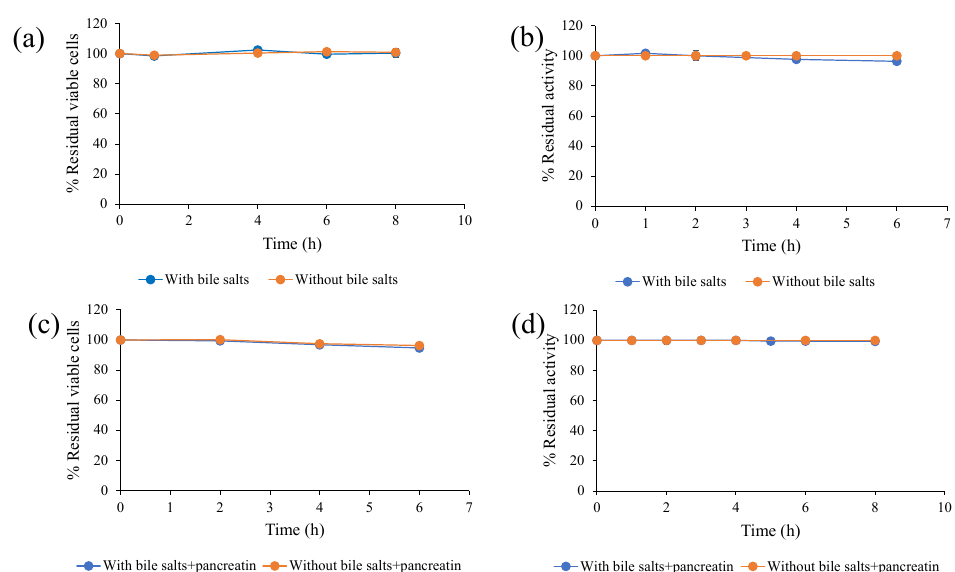
Figure 2. E ff ect of bile salts on ( a ) survival of S. ruineniae A45.2 and ( b ) residual CAT activity and e ff ect of pancreatin in combination with bile salts on ( c ) survival of S. ruineniae A45.2 and ( d ) residual CAT activity.